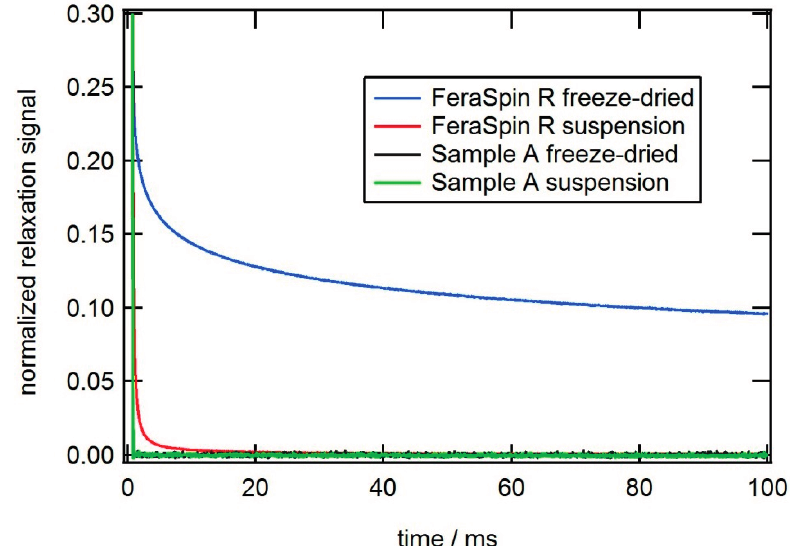
Figure 10. Normalized signal of the relaxation cycle of a MRX (magnetorelaxometry) measurement recorded on sample A in comparison to FeraSpin™-R with the fluxgate setup. No difference between suspended and immobilized particles is discernable for Sample A in contrast to